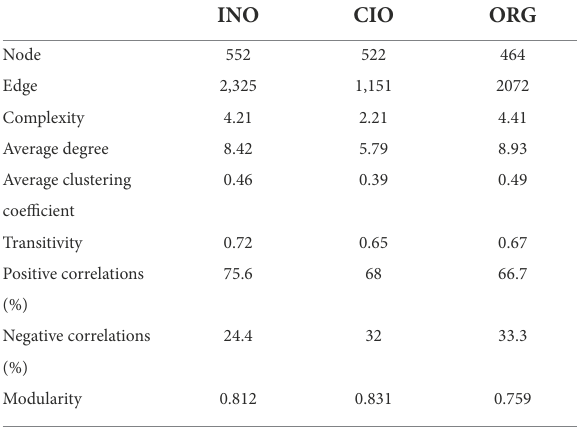
TABLE 3 Topological properties of bacteria-fungi networks under three N regimes. INO